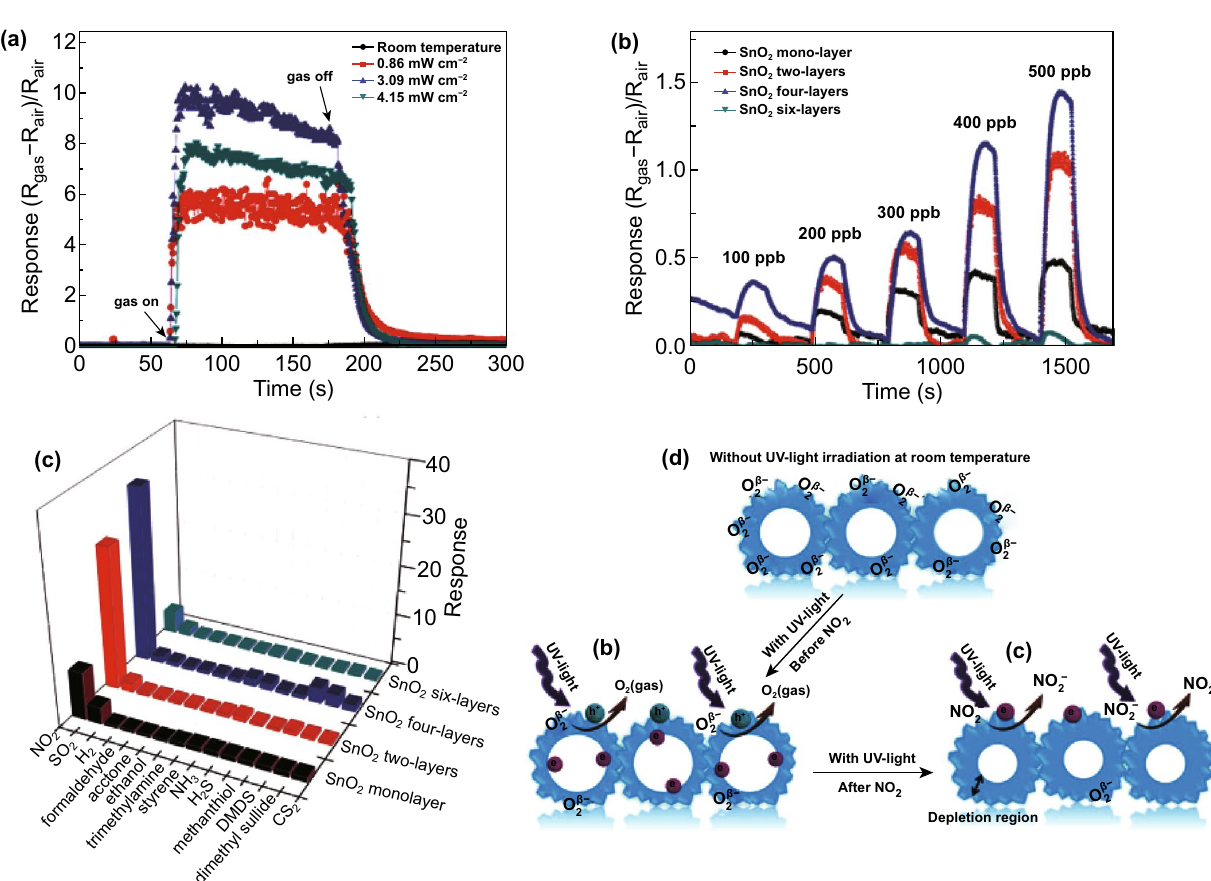
Fig. 5 Response–recovery curves of a SnO 2 monolayer array film towards 10 ppm NO 2 under different light intensity and b SnO 2 film with dif- ferent thickness towards 100–500 ppb NO 2 under the UV light intensity of 3.09 mW cm −2 , c corresponding sensor responses to 10 ppm NO 2 . d Sensing mechanism of the